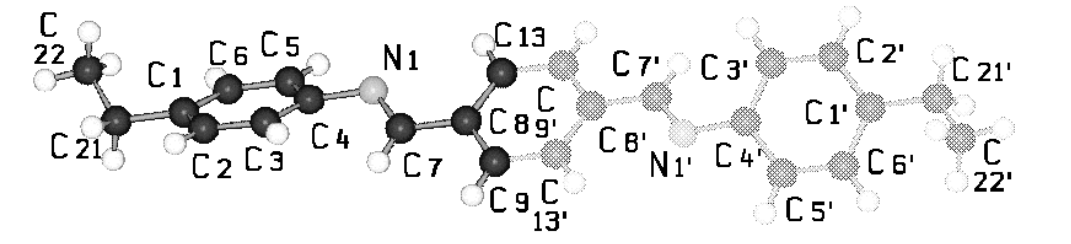
Figure 23. Representation of the conformation of TBAA-2 with an inversion center within phenyl plane 2 ( cf. Scheme 2) and atom numbering. TBAA-0 and TBAA-1 can be similarly described. Note: a symmetric twisting occurs for the phenyl planes 1 → 2 with regard to 2 → 3 for the conformation of the three compounds, but different twisting angles are observed for each of the TBAA- n ( n = 0–2) compound ( cf. Table 9). The asymmetric unit consists of half a